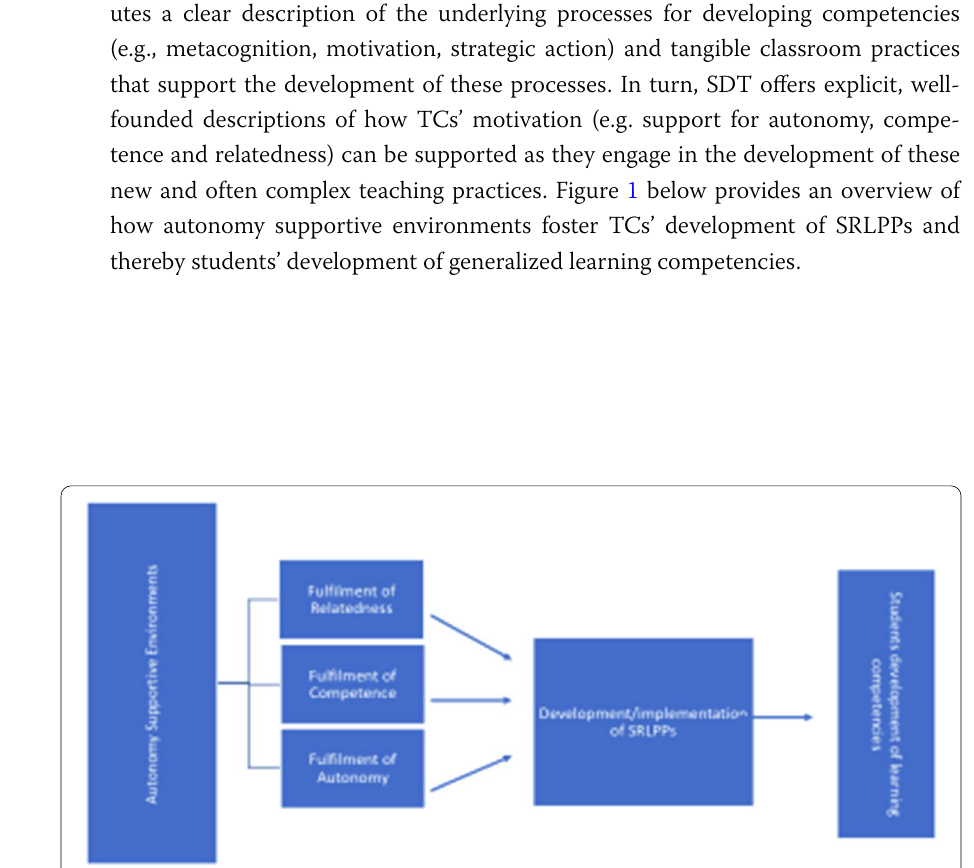
Fig. 1 Fostering TCs’ SRLPPs through autonomy supportive